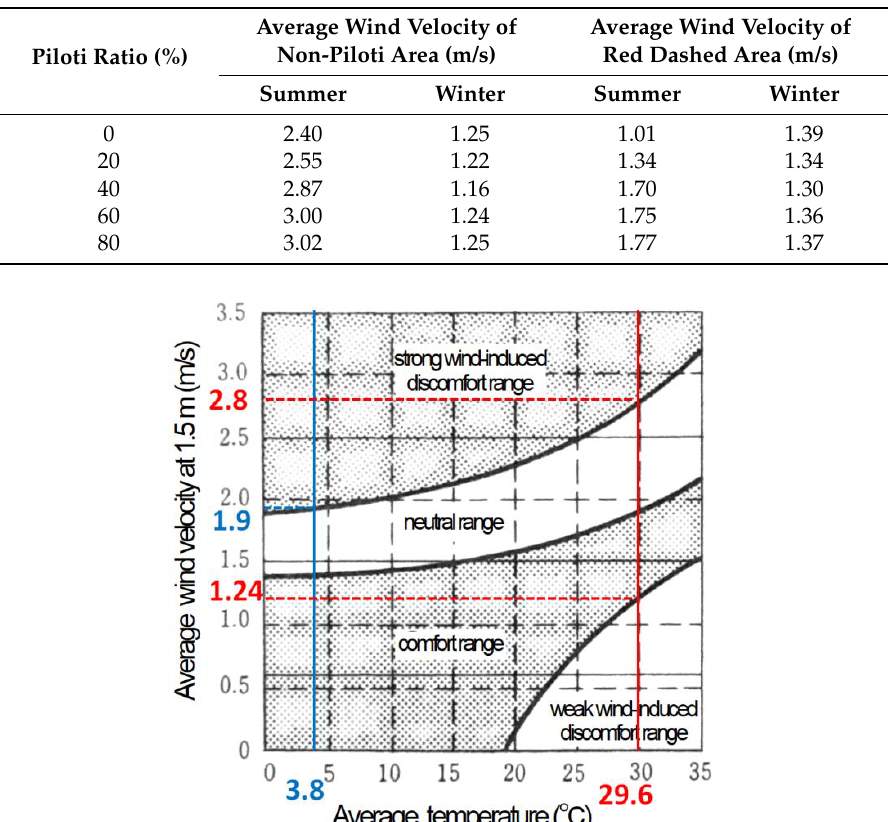
Table 10. The relationship between the piloti ratio and the average wind velocity.